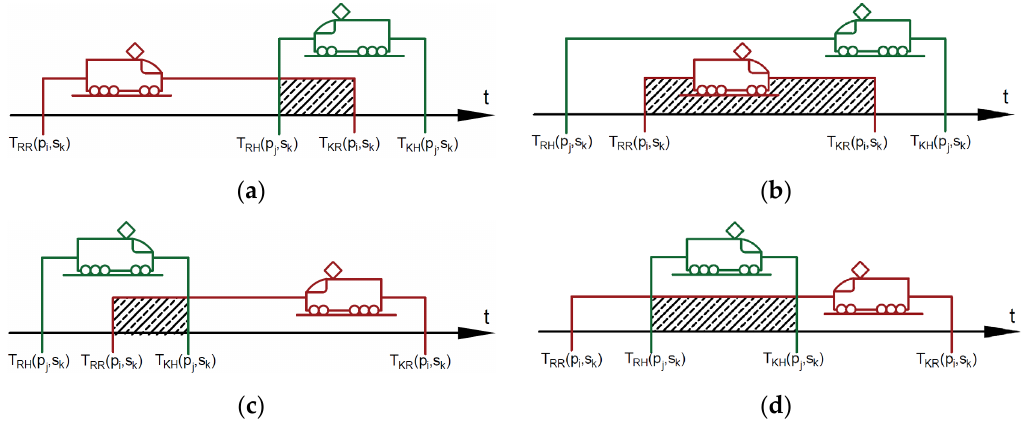
Figure 1. Each situations, ( a – d ), where the energy cooperation of trains is possible. Source: own study.